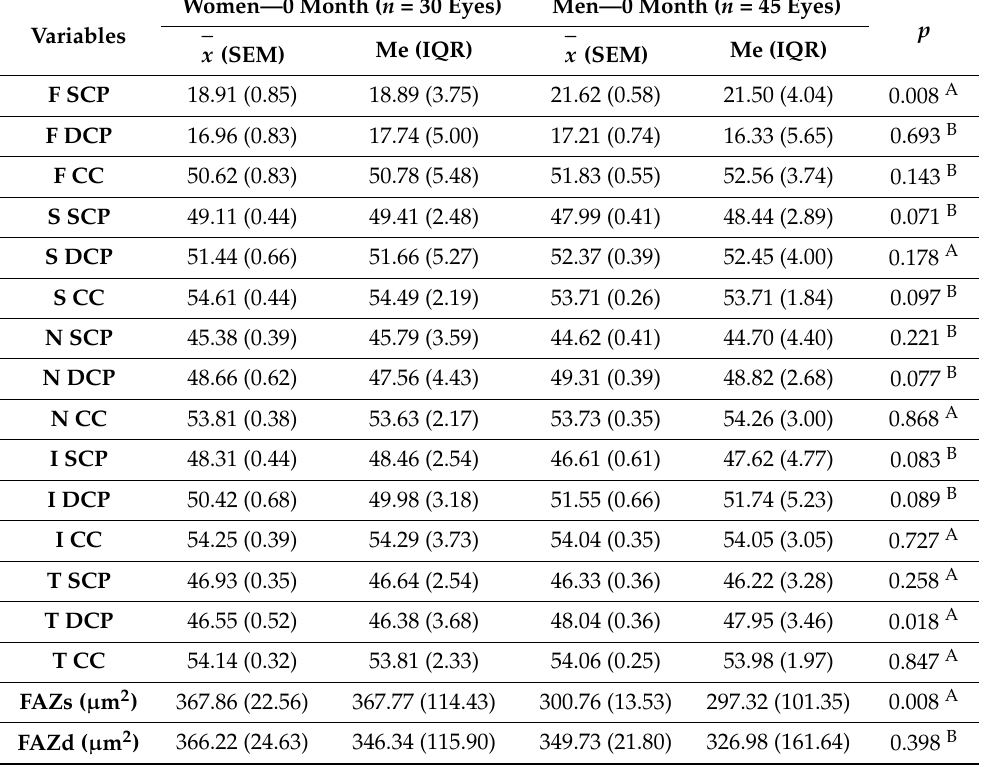
Table 4. Comparison of foveal (F) and parafoveal parameters of OCTA (optical coherence tomography angiography) parameters between women and men in COVID-19 patients in 0 month: SCP-superficial capillary plexus, DCP—deep capillary plexus, CC—choriocapillaris, FAZ s—superficial foveal avas-